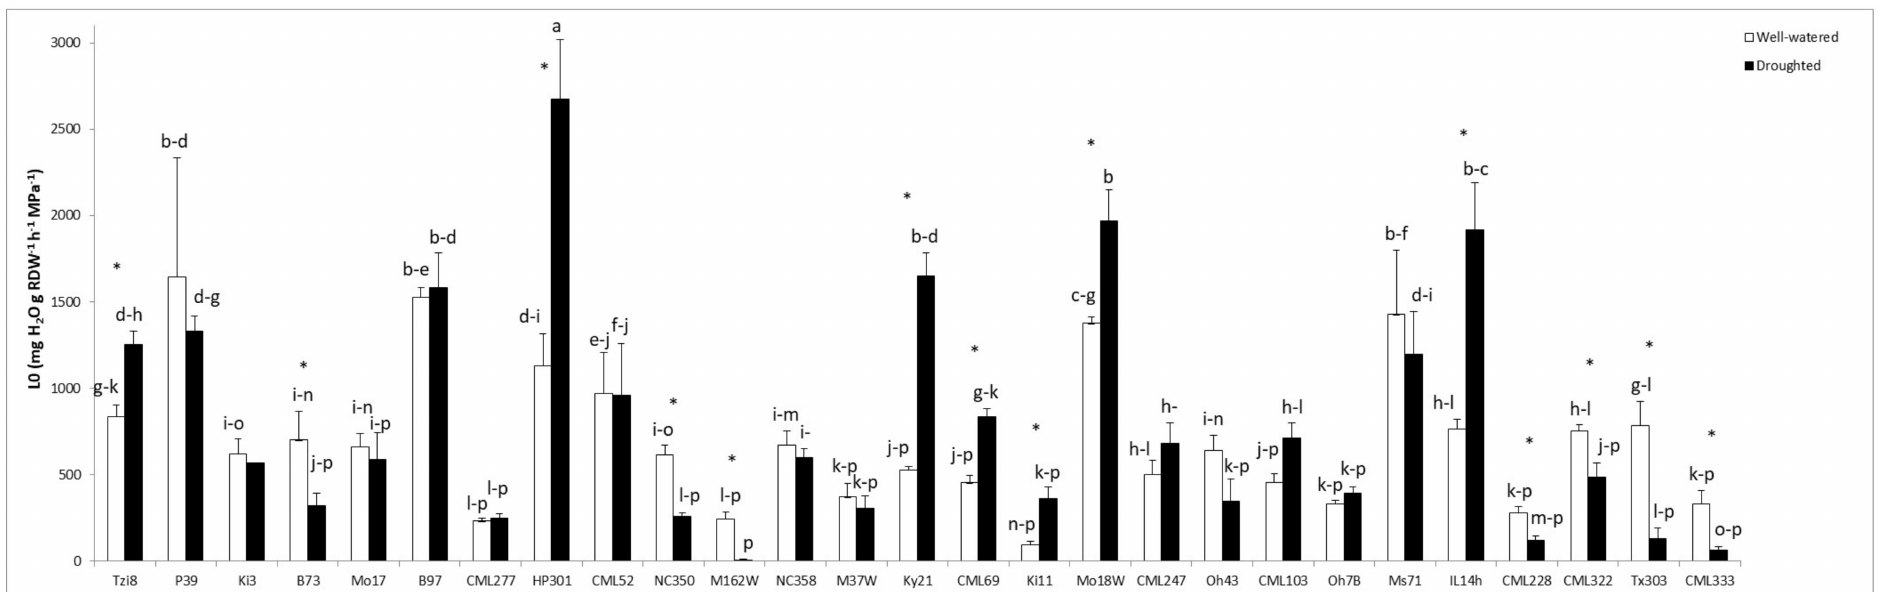
Figure 3. Osmotic root hydraulic conductivity (Lo) in the whole maize NAM population cultivated under well-watered conditions or subjected to drought stress. Data represents the means of 6 values ± S.E. Different letters indicate significant differences between treatments ( p < 0.05) based on Duncan’s test. Asterisks indicate significant differences between well-watered and droughted treatments within each maize line, according to Student’s t